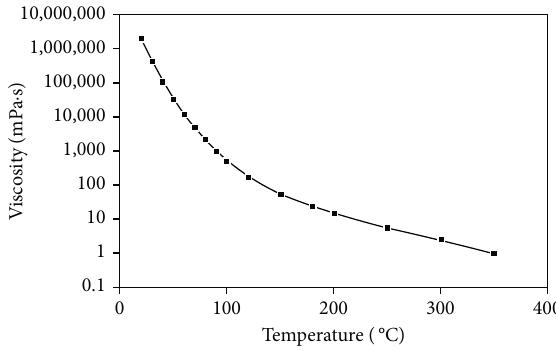
Figure 3: The oil viscosity-temperature curve of the